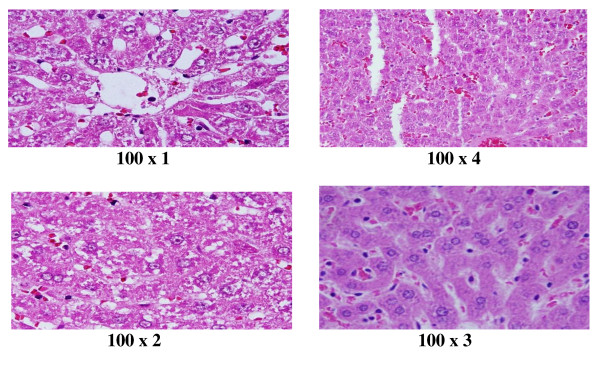
GNPs-treated rat received 100 μl of 10 nm particles for 7 days